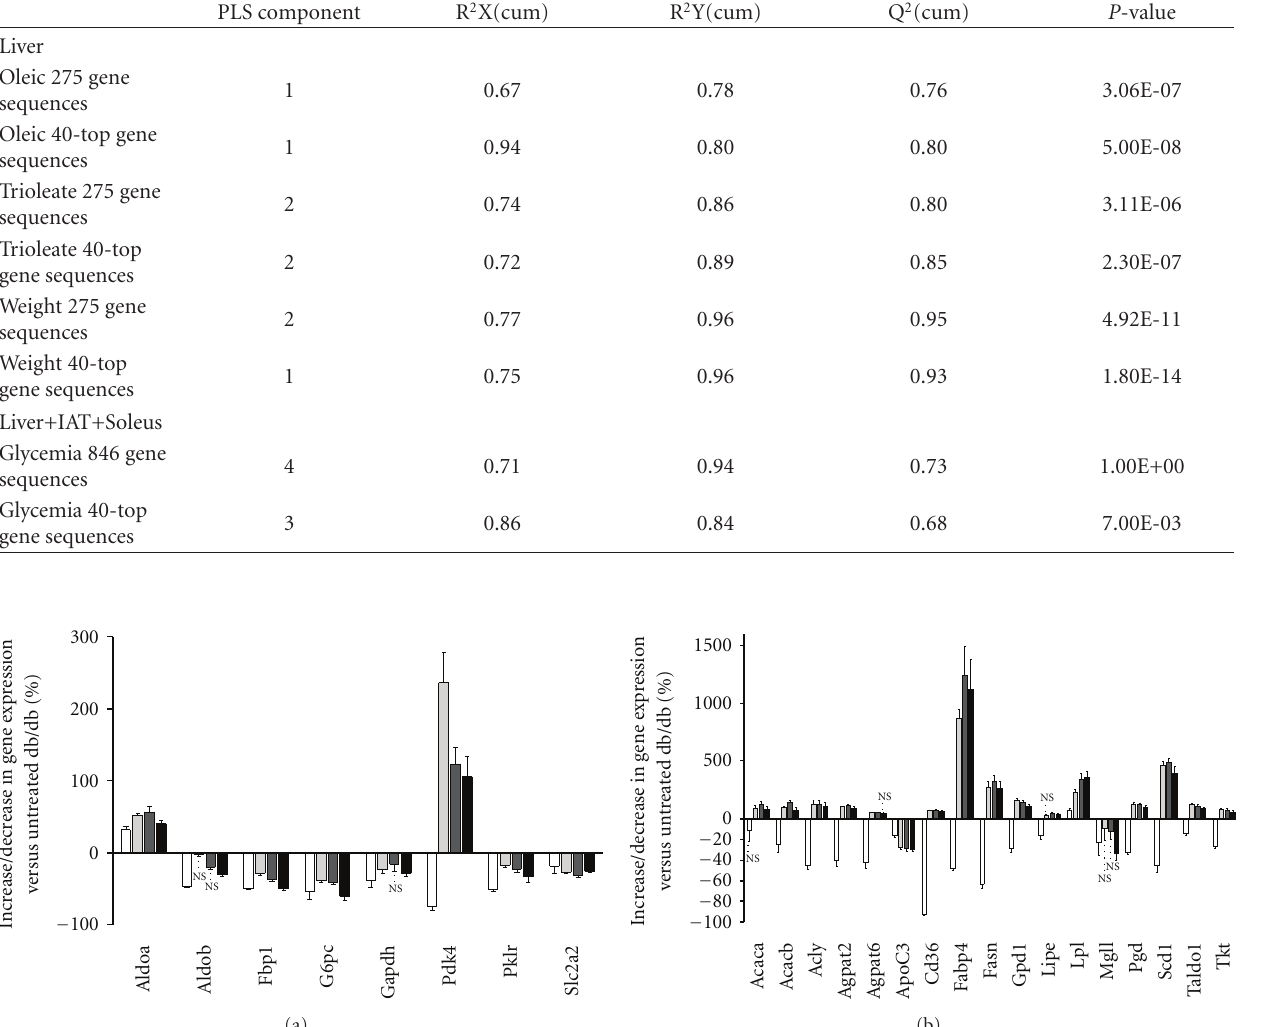
e ff ect, that is, untreated nondiabetic db/+ versus diabetic mice db/db. Consequently, RSG-induced normalisation of gene expression is defined as genes that were significantly changed by RSG (RSG-treated db/db versus db/db) in the same direction as nondiabetic (db/+ versus db/db)